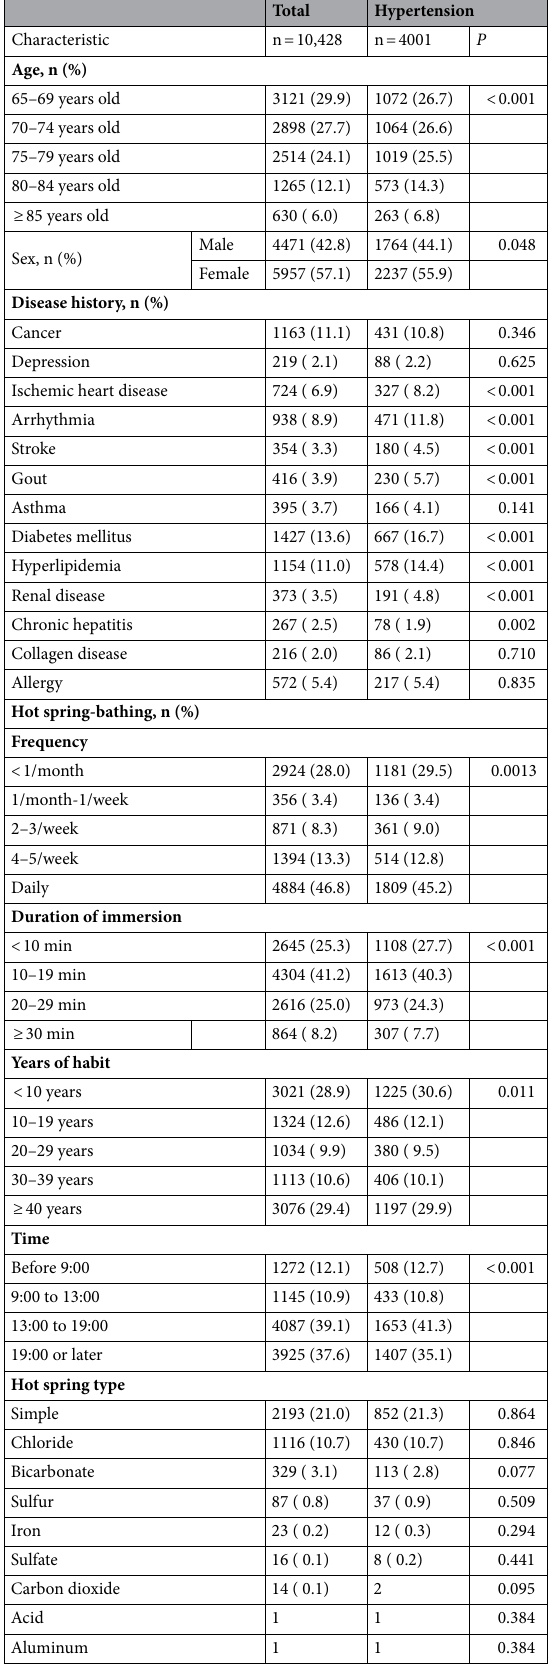
Table 1. Characteristics of survey respondents. The p -values were obtained using the chi-square